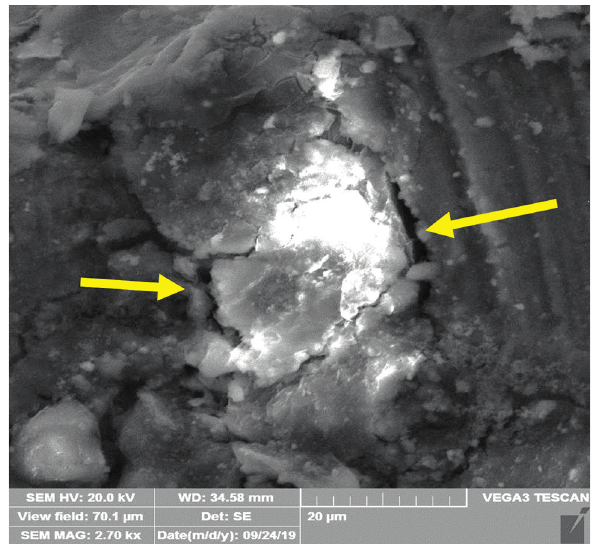
Figure 9: SEM image of grain boundary precipitation and cracks (sample3).